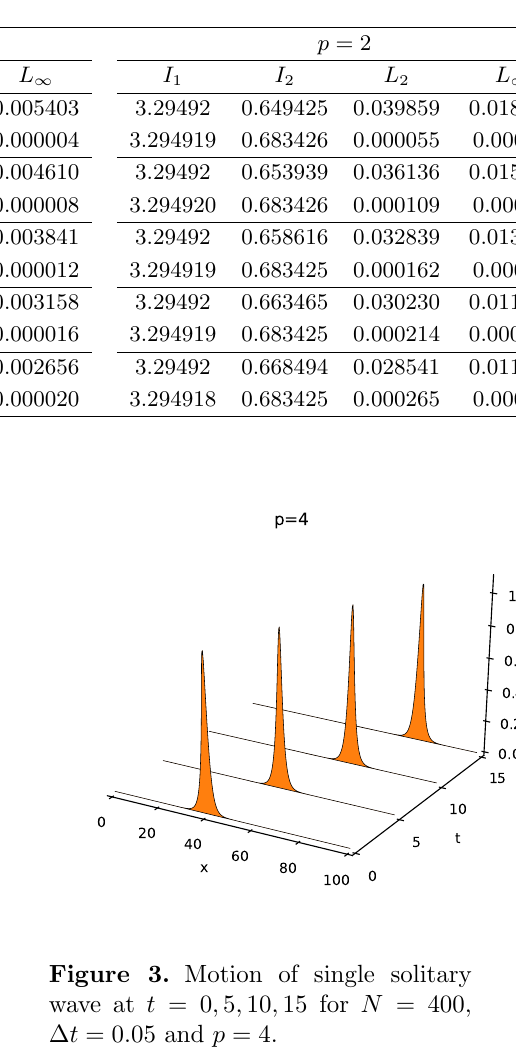
Table 8. Comparison of the results on 0 ≤ x ≤ 100, µ = 1 , x 0 = 40 and ∆ t = c = 0 . 1.